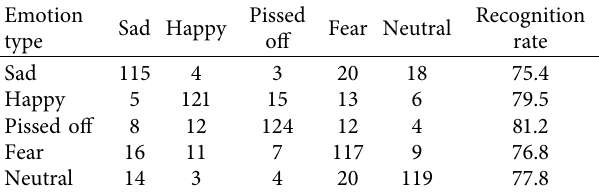
Table 3: Emotion recognition results under 810 training amounts.